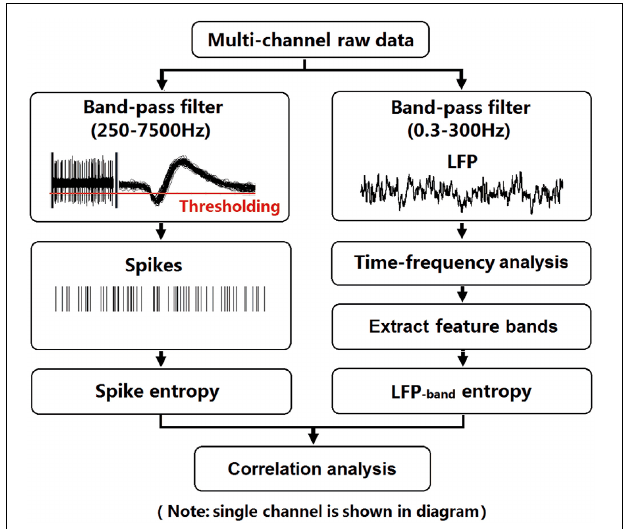
FIGURE 2 | Flow chart for data analysis. To illustrate the procedure, we selected an arbitrary single channel to display. LFPs (band-pass filter: 0.3–300Hz) were obtained from raw data via digital filters. Feature bands were further extracted according to the results of time-frequency spectral analysis. Spikes (band-pass filter: 250–7500Hz) exceeding a preset voltage threshold were sampled at 30kHz and were stored with time stamps. Then, entropy estimation of LFPs and spikes were performed. Finally, the correlation of spike entropy and LFP entropy was calculated to assess the spike-LFP